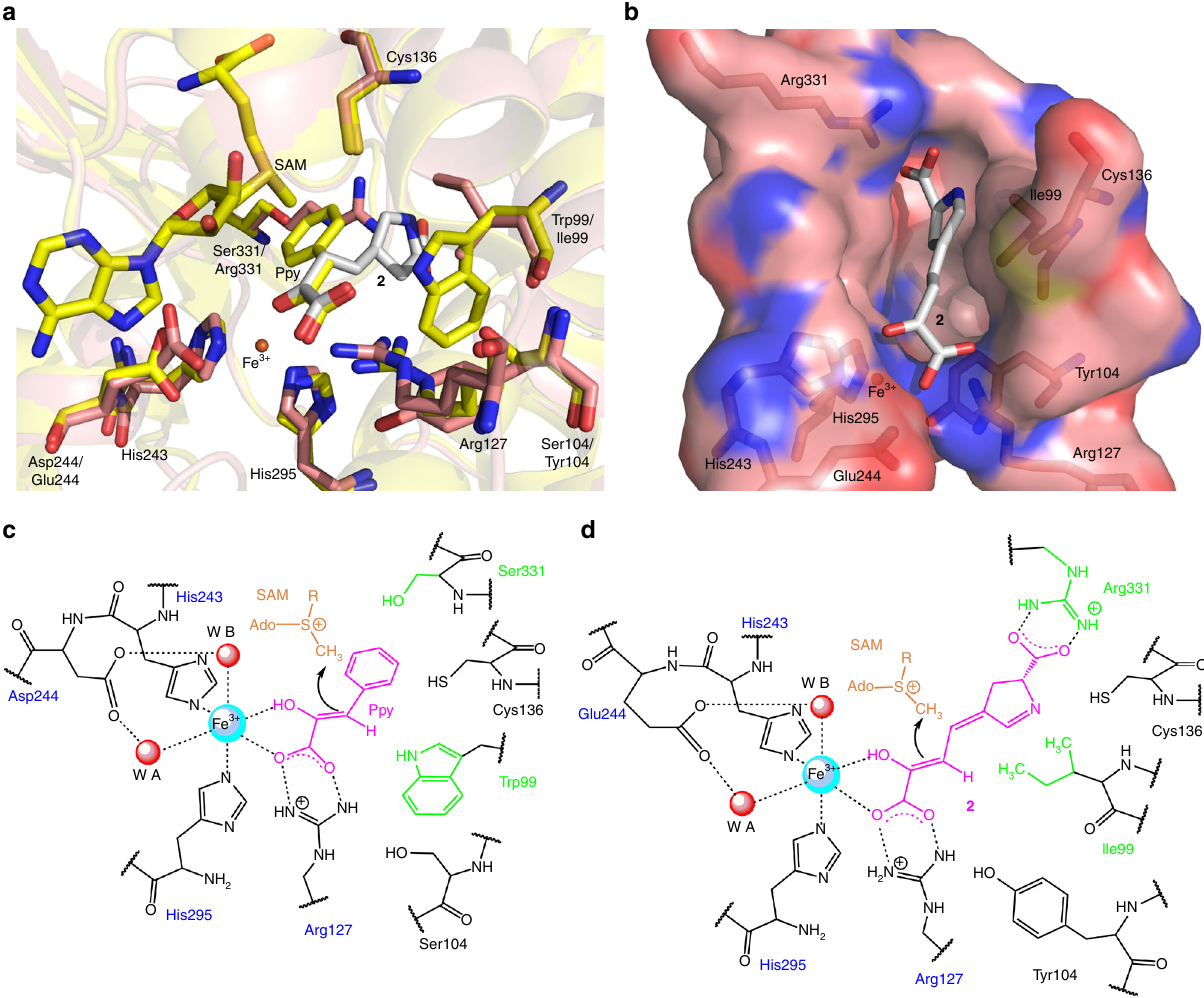
Fig. 2 Comparison of the active sites and proposed reaction mechanism of MppJ and LmbW. a Comparison of active sites of MppJ (in yellow, crystal structure PDB ID: 4KIC [https://www.rcsb.org/structure/4KIC] with the substrates phenylenolpyruvate (Ppy) and S -adenosyl methionine (SAM) — adopted 6 ) and LmbW (a homology model built using the MppJ structure and the SWISS-MODEL server 15 ); LmbW is in pink; substrate 2 is in white. The positions of compound 2 , Fe 3 + , and SAM in the model were determined by superimposing the model on the 4KIC template in PyMOL 16 and adjusting the position of 2 based on the position of the α -keto(enol)-carboxylic moiety of Ppy bound to MppJ. b Arrangement of the putative substrate binding pocket with 2 in the homology model of LmbW. c Schematic active site and a proposed mechanism of action of MppJ 6 , modi fi ed according to panel a . d Schematic active site and proposed mechanism of action of LmbW. Panels c and d : abbreviations of residues re fl ecting the common α -keto(enol)-carboxylic moiety of Ppy and 2 and the common proposed mechanism are in blue; abbreviations of residues differing in MppJ vs. LmbW, re fl ecting the uncommon moieties of Ppy vs. 2 (aromatic ring of Ppy vs. heterocyclic carboxylic moiety of 2 ), are in green. Residue numbering corresponds to